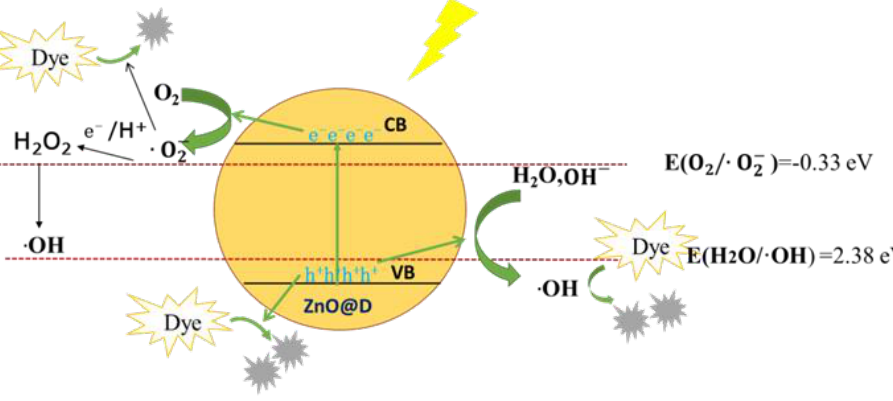
Scheme 1. Schematic illustration of the formation of ZnO@diatomite composite catalysts.